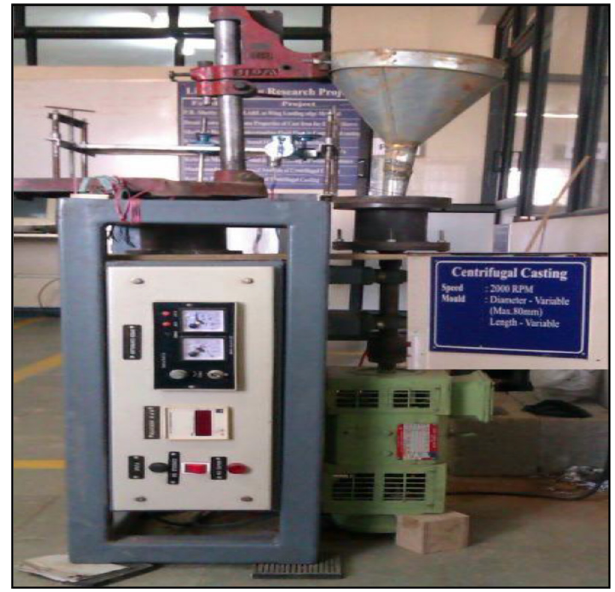
Fig. 1. Vertical centrifugal casting